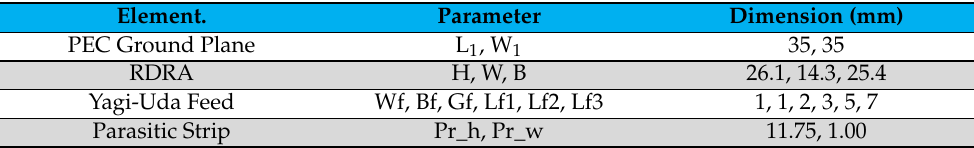
Table 1. Best estimates of proposed wideband RDRA and feeds dimensions. Element.